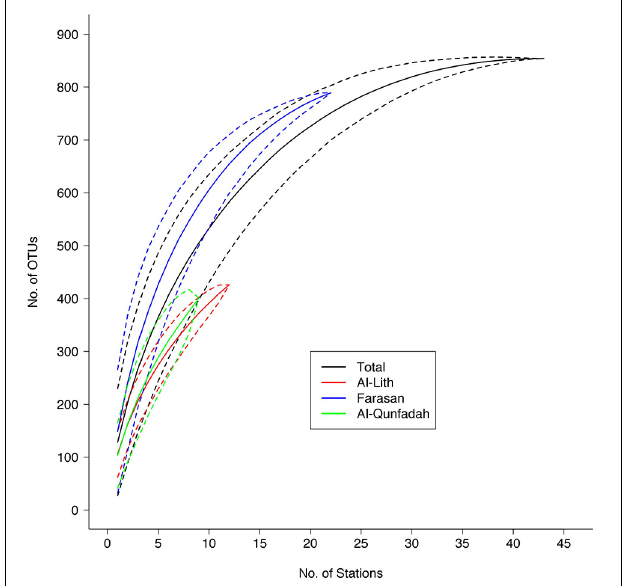
FIGURE 2 | Rarefaction curve (with 95% confidence limits) showing the number of metazoan OTUs observed with increasing number of sampling stations for the 1389F primer